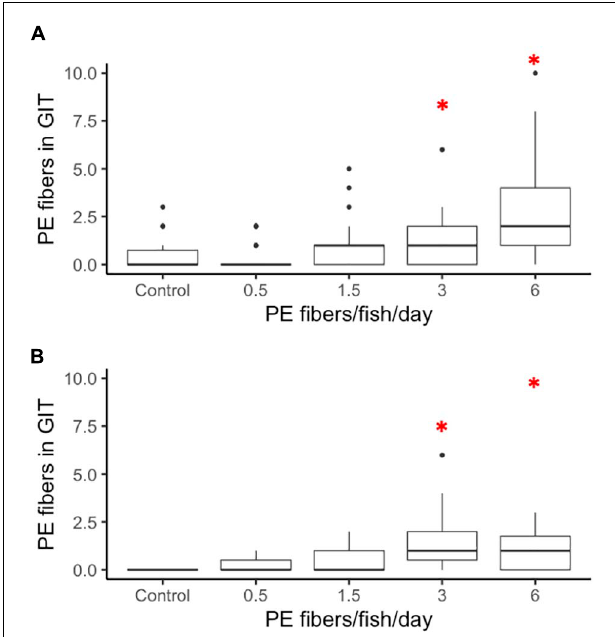
FIGURE 3 | Long term retention of PE fibers in (A) larvae and (B) juveniles O. latipes after 21 days of exposure to control (0), 0.5, 1.5, 3, and 6 fibers/fish per day. Red stars indicate significant differences revealed by a nested ANOVA, ∗ p < 0.05, n =